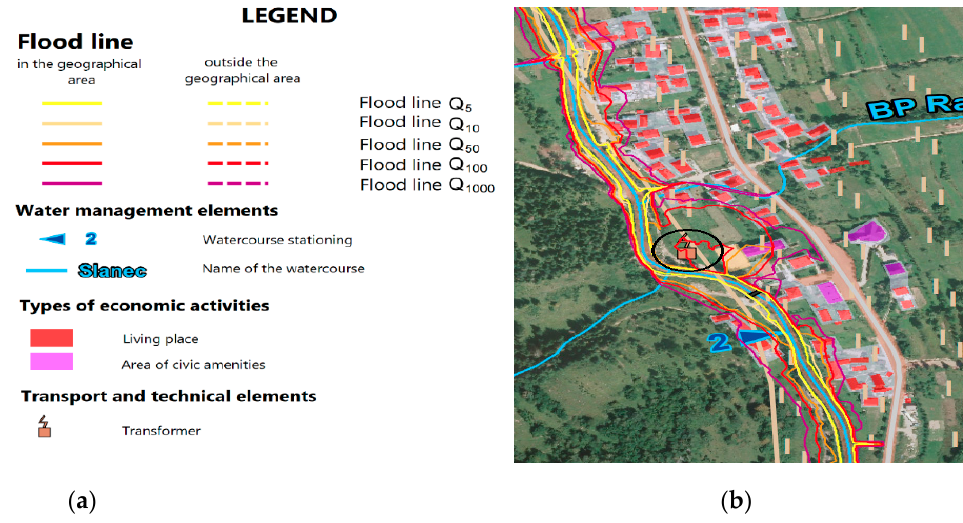
Figure 5. ( a ) Flood map legend; ( b ) flood map of Radôstka [60].